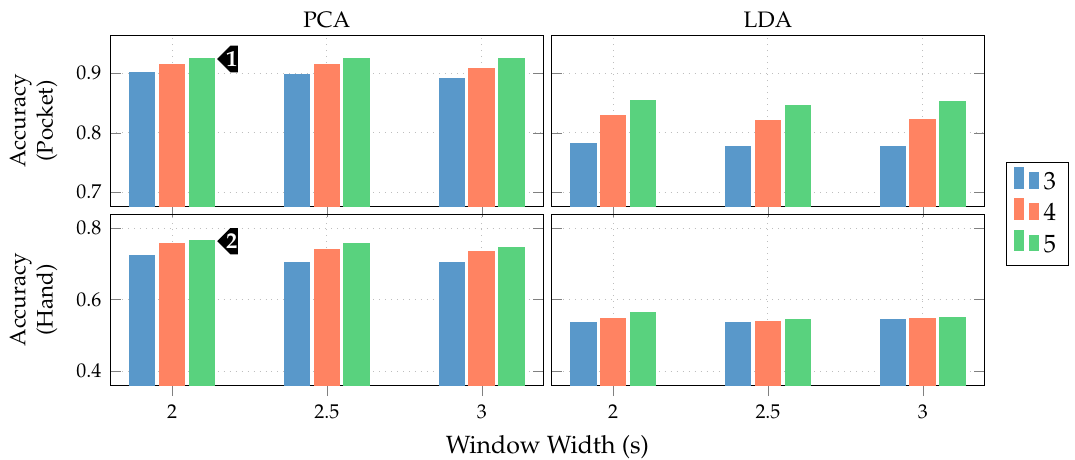
Figure 13. Comparison of the resulting classification accuracies when using the approach based on analytical transformations for different window lengths and dimensions (blue 3, red 4, green 5) with PCA and LDA on both pocket-case and